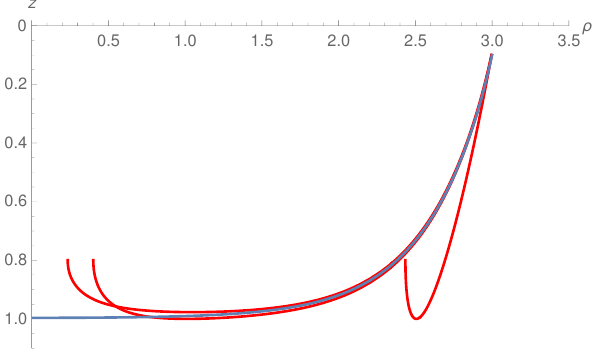
Figure 13 . Double loops in the regions (i), (ii) and (iii) for the same outer radius R 2 = 3 : 0 and inner quark mass m q = 0 : 62 (corresponding to z m to (cid:26) = 0 is a single loop with the same radius R 2 = 3 :